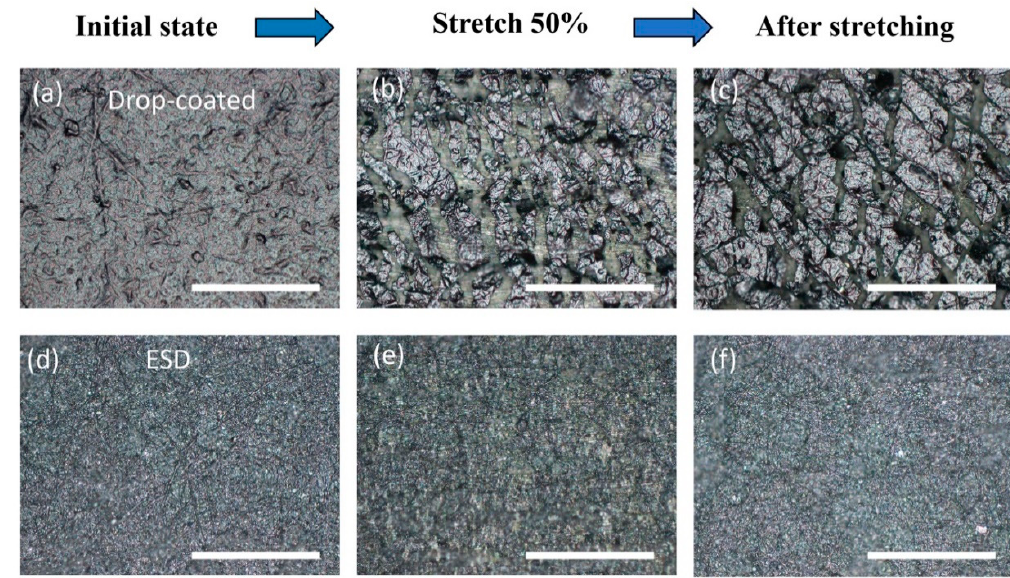
Figure 5. Optical images of drop coated sensing layer in the initial state ( a ) and stretched states by 50% ( b ) and after stretching ( c ); Optical images of ESD sensing layer in the initial state ( d ) and stretched states by 50% ( e ) and after stretching ( f ). The scale bar is 200 μ m.